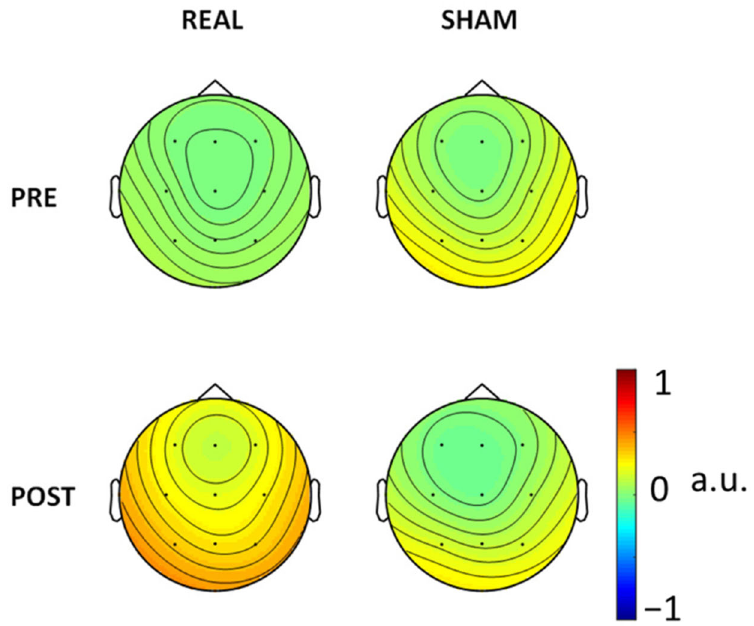
Figure 4. FS_rp topographical representation.